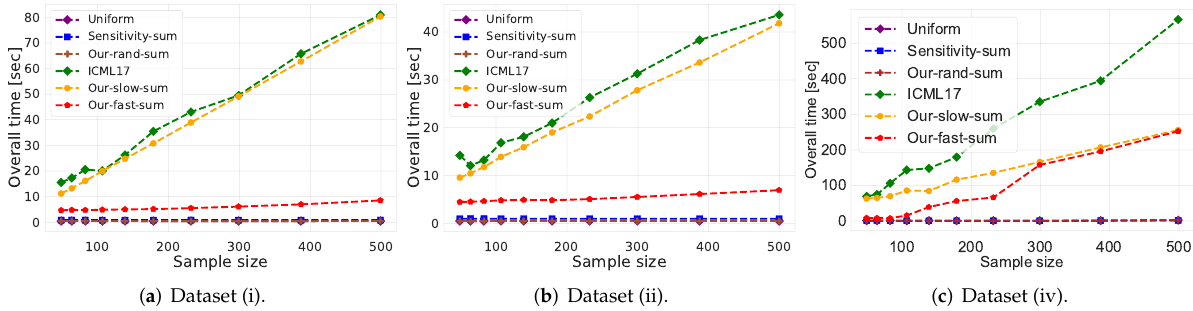
Figure 3. Experimental results for vector summarization. The x axis is the size of the subset (coreset), while the y axis is the overall time took to compute the coreset and to solve the problem on it. The difference between the two graphs is the chosen dataset.